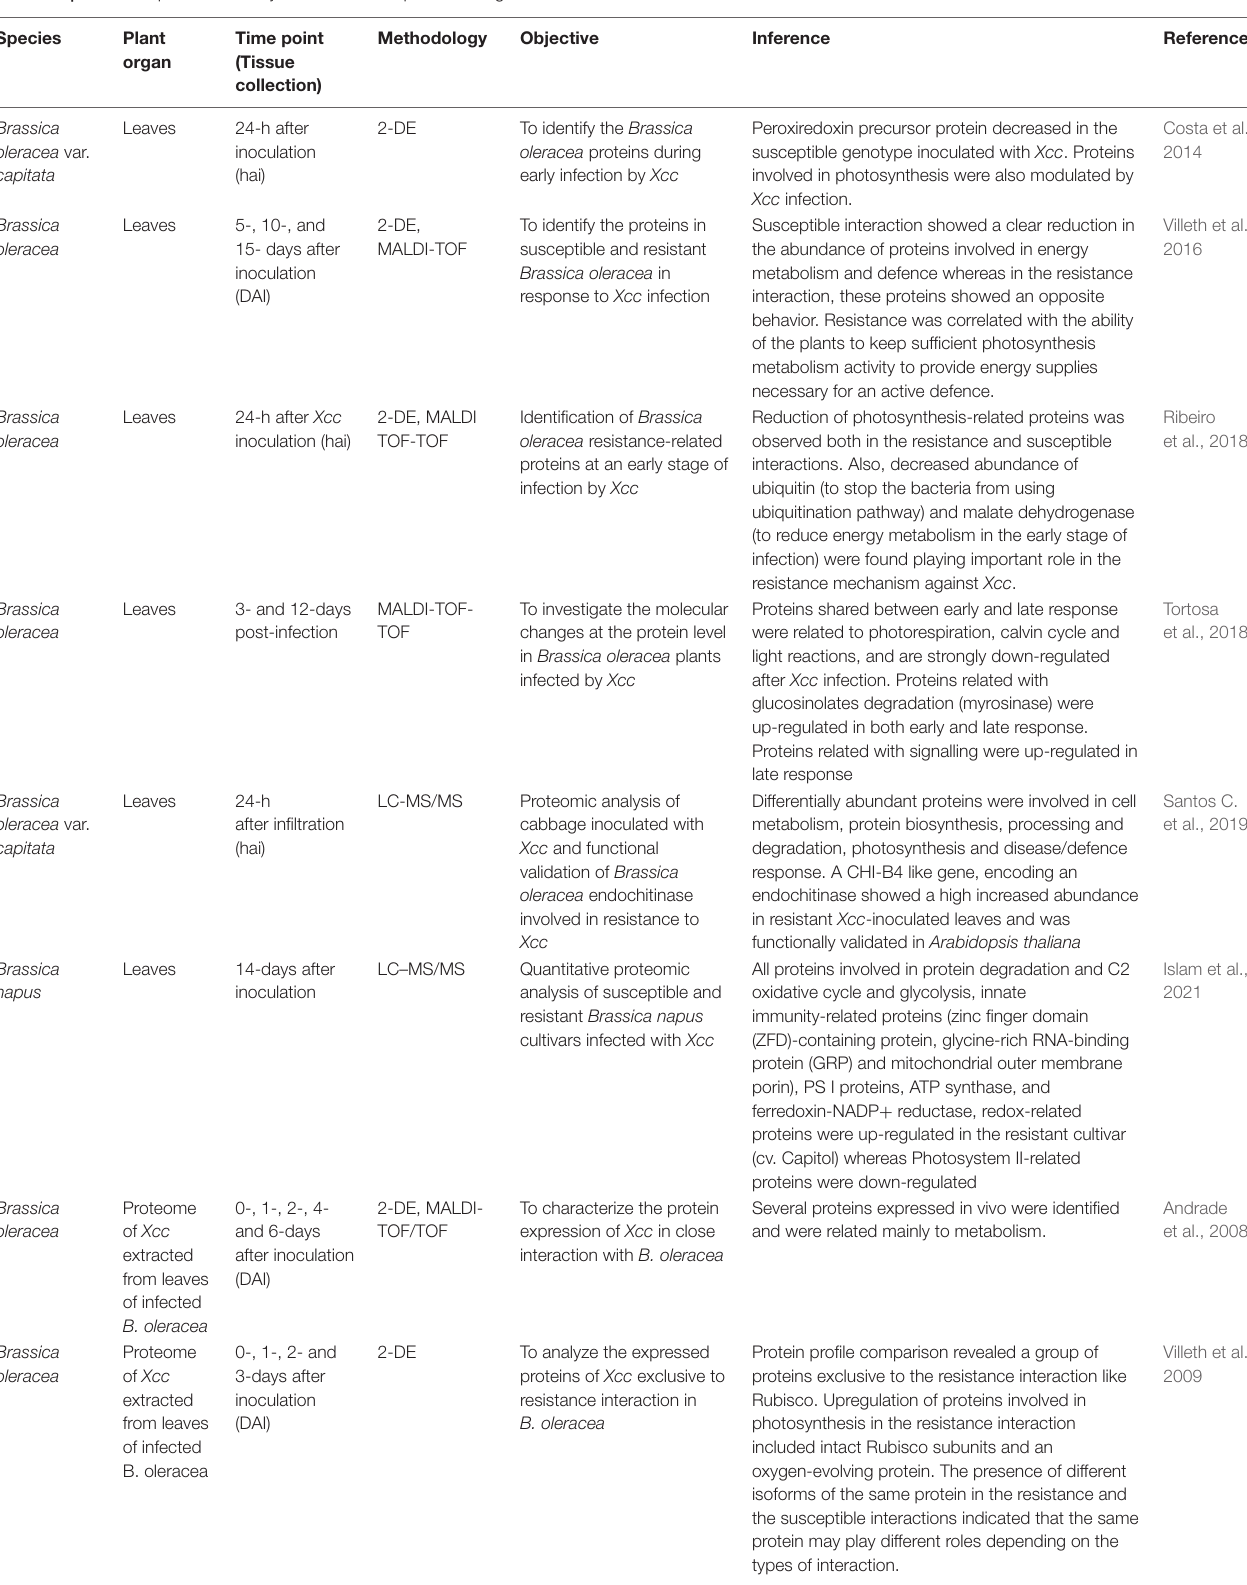
TABLE 4 | Published proteomic analyses in Brassica species during interaction with black